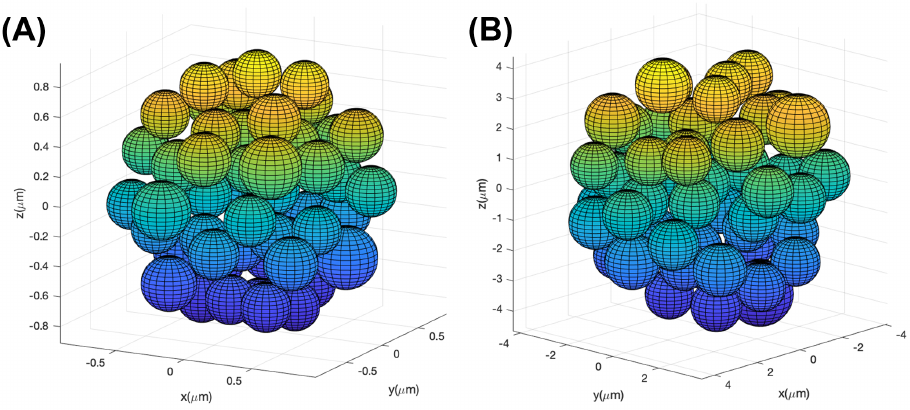
Figure 1. Representative aggregate framework for a ( A ) 2 µ m and a ( B ) 10 µ m overall cluster diameter. The 2 µ m diameter aggregate is comprised of constituent spherical particles having a diameter of 0.38 µ m while the spherical particles that make up the 10 µ m aggregate are 1.9 µ m in diameter. These are simply examples of cluster morphology and different frameworks were created that were comprised of different constituent particle sizes.